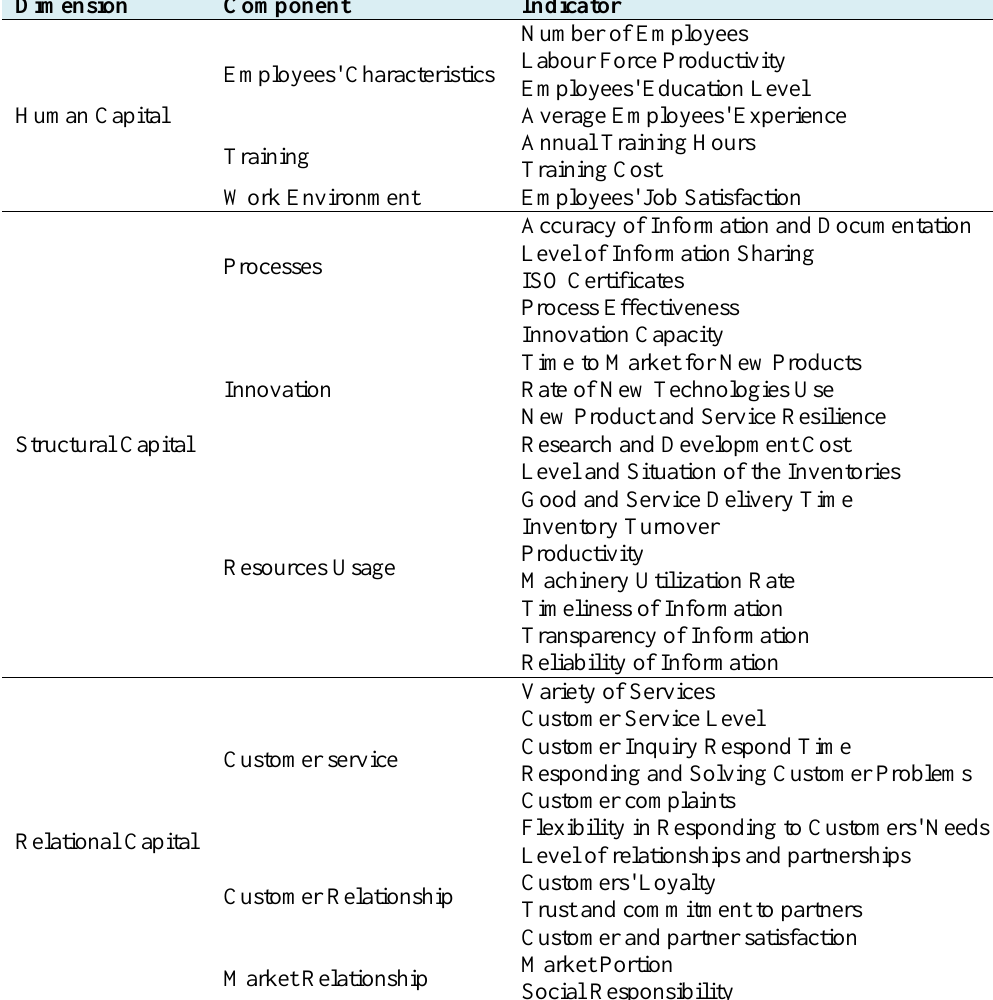
Table 1. Dimensions, Components, and Indicators of Intellectual